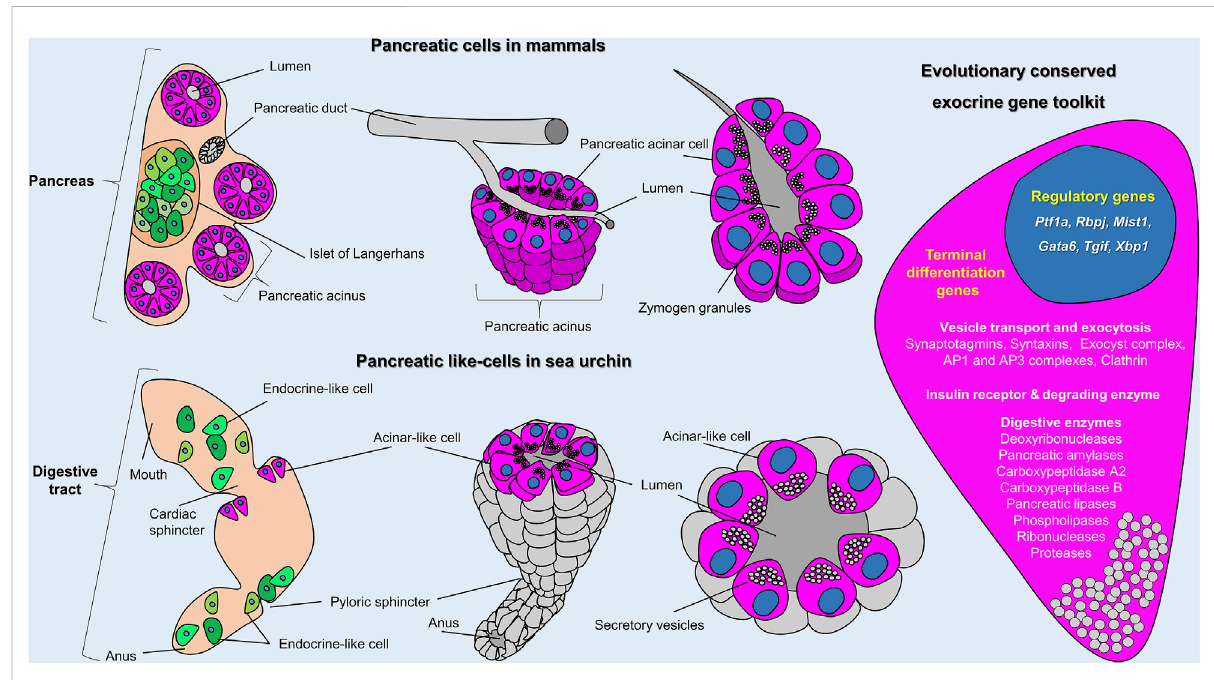
FIGURE 5 Sea urchin acinar-like cells. Schematic representation summarizing the molecular and morphological conserved features of vertebrate acinar and invertebrate acinar-like cells as shown in this study. Cartoons show the distribution and organization of pancreatic cells in mammals (top row) and sea urchin (bottom row) and (on the right) an overview of the evolutionary conserved gene toolkit shared between sea urchin and mammalian exocrine pancreatic cells. In mammals, exocrine (magenta) and endocrine (green) cells coalesce into a single organ; the pancreas. In sea urchins, acinar-like (magenta)and endocrine pancreas – like (green) cells are scatteredwithin the digestive tract. The cartoon on the right represents an overview of the evolutionary conserved regulatory and terminal differentiation genes found both in mammalian and sea urchin exocrine cells. A full gene list of the sea urchin transcripts found in the acinar-like cell type family can be found in Supplementary Files 2 and